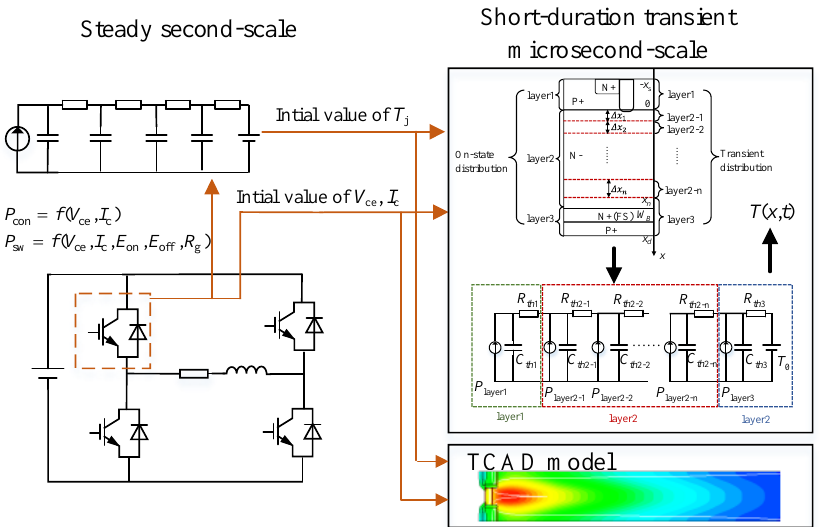
Table 6. Multi-timescale joint simulation time.